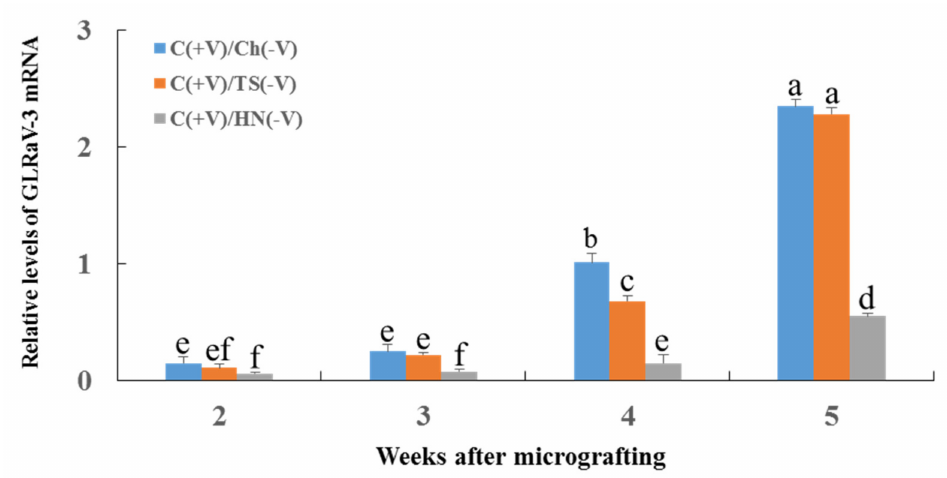
Figure 6. Relative level of GLRaV-3 of rootstocks from the scions of ‘Cabernet Sauvignon’ in- fected GLRaV-3 at different weeks after micrografting. C, Ch, TS, and HN = ‘Cabernet Sauvignon’, ‘Chardonnay’, ‘Thompson Seedless’ and HN-1, respectively. +V = virus-infected scion. –V = virus- free rootstock. Data presented as means ± SE; The different letters are significantly different at p <